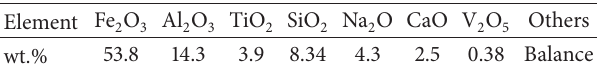
Table 2: Chemical composition of red